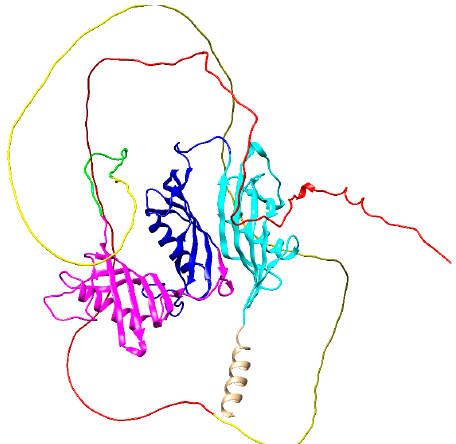
Figure 3. AlphaFold prediction of human HK. Colors of domains according to Figure 2. The struc- ture contains a signal peptide colored brown. The figure was prepared in UCSF Chimera 1.15 based on downloaded AlPhaFold PDB coordinates (accessed date 29 October 2021) [50,51].